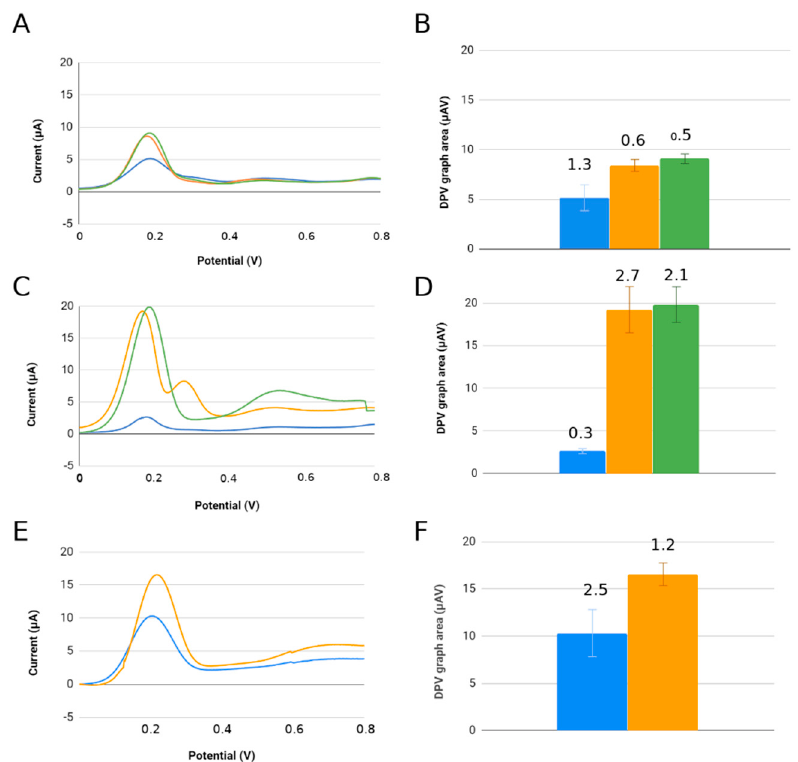
Figure 5. Results of differential pulse voltammetric readings using 4-DMAA before serum: ( A , B ) strongyloid D3 probe (peaks 9.09, 8.91, and 5.15 µ A); ( C , D ) tegumentary leishmaniasis LT probe (peaks 19.84, 19.14, and 2.62 µ A); ( E , F ) leprosy M3R probe (peaks 16.55 and 10.30 µ A). Bars: blue = serum-positive, yellow = serum-negative, and green = controls (control was absent in F). Graphs showing current range − 5 to 20 µ A and potential 0 to 0.8 V (same scale for all probes). Electrolyte: phosphate-buffered saline (pH 7.4).